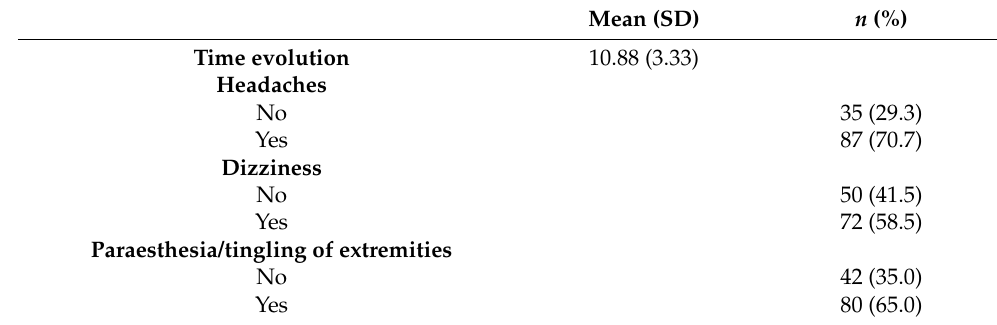
Table 1. Descriptive clinical variables.